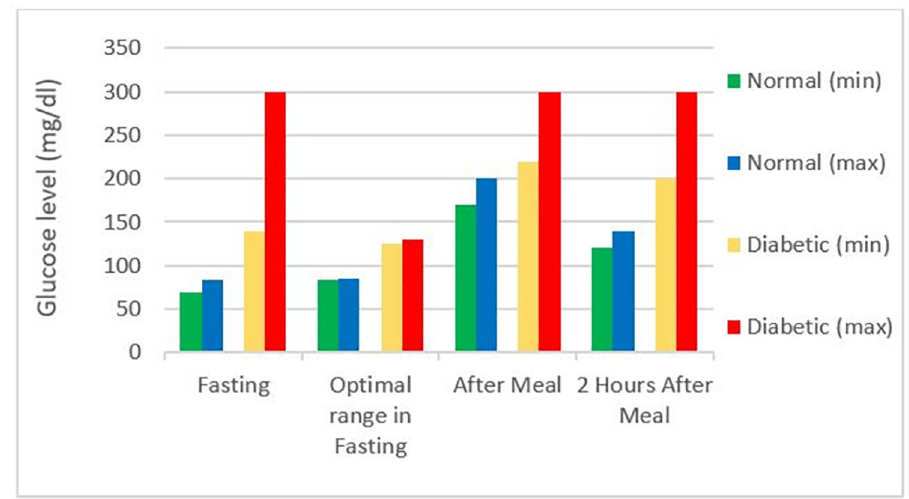
Fig 11. Glucose levels of normal and diabetic subjects [28].